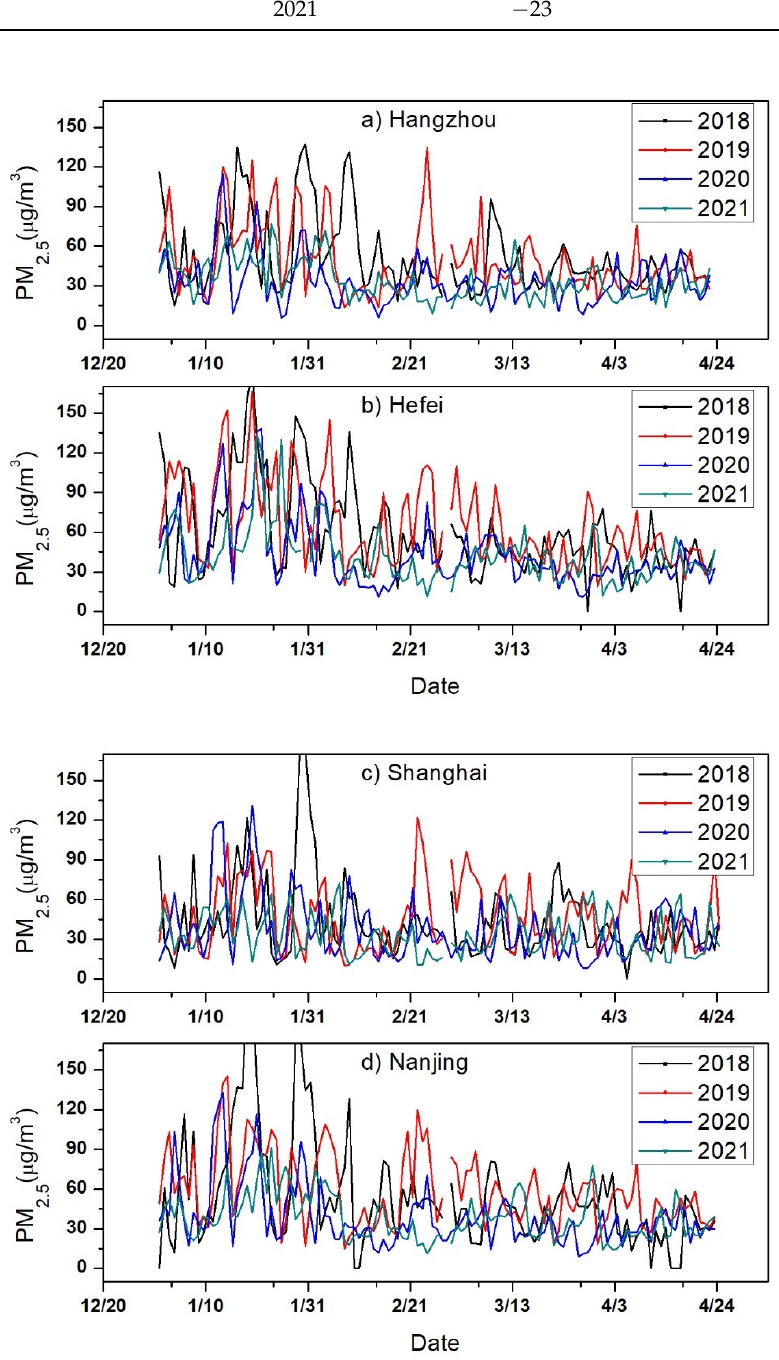
Figure 3. Time series of daily averaged PM 2.5 over the studied cities. 3.3. O 3 The trend in O 3 concentration is opposite to that of other atmospheric pollutants.